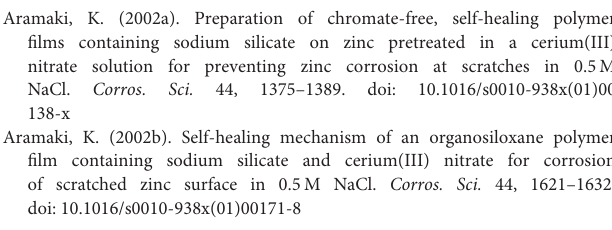
Supplementary Figure S1 | Schematic representation of the synthesis of the diblock copolymer onto the surface of either CeO 2 or Cu 2 O. Supplementary Figure S2 | SEM surface images and line elemental EDS analysis of the artificially scribed: (a) Epoxy-PBA-CSmc and (b) Epoxy-CSmc coating systems. Supplementary Figure S3 | XRD pattern of the CeO 2 @P(BA-b-AA) core-shell microcapsules. Supplementary Figure S4 | XRD pattern of the of the Cu 2 O@P(BA-b-AA) core-shell microcapsules. Supplementary Figure S5 | SEM surface images of the: (a) Epoxy-PBA-CSmc and (b) Epoxy-CSmc corrosion protective coating systems. Supplementary Figure S6 | Topographic maps with the average coating thicknesses of the: (a) Epoxy-PBA-CSmc and (b) Epoxy-CSmc corrosion protective coating systems. Supplementary Figure S7 | SEM cross-section images of the coating thicknesses of the: (a) Epoxy-PBA-CSmc and (b) Epoxy-CSmc corrosion protective coating systems. Supplementary Figure S8 | EIS Bode diagrams of artificially scribed Epoxy-PBA-CSmc after exposure to 5mM NaCl solution: (a) Impedance modulus versus frequency and (b) Phase angle versus frequency. Supplementary Figure S9 | EIS Bode diagrams of artificially scribed Epoxy-CSmc after exposure to 5mM NaCl solution: (a) Impedance modulus versus frequency and (b) Phase angle versus frequency. Supplementary Figure S10 | EIS Bode diagrams of artificially scribed Epoxy-PBA-CSmc and Epoxy-CSmc coatings, before and after heat-induced healing after exposure to 5mM NaCl solution: (a) Impedance modulus versus frequency and (b) Phase angle versus frequency. Supplementary Figure S11 | EIS Nyquist diagrams of artificially scribed Epoxy-PBA-CSmc and Epoxy-CSmc coatings, before and after heat-induced healing after exposure to 5mM NaCl solution. Supplementary Figure S12 | The DSC measurements conducted on the scribed Epoxy-PBA-CSmc coating after thermal treatment at 90 ◦ C for 30 min. Supplementary Table T1 | Chemical Composition of Substitute Ocean Water (according to ASTM D1141-98). Supplementary Table T2 | The morphological and structural characteristics of the CeO 2 @P(BA-b-AA) core-shell microcapsules. Supplementary Table T3 | The morphological and structural characteristics of Cu 2 O@P(BA-b-AA) core-shell